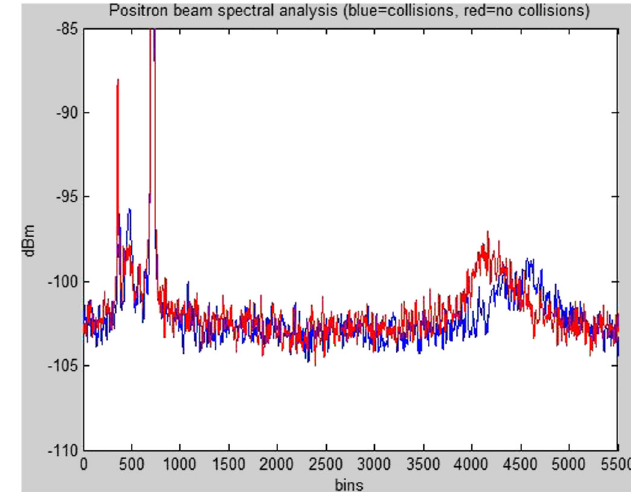
FIG. 2. Synchrotron sidebands damped by beam-beam colli- sions.